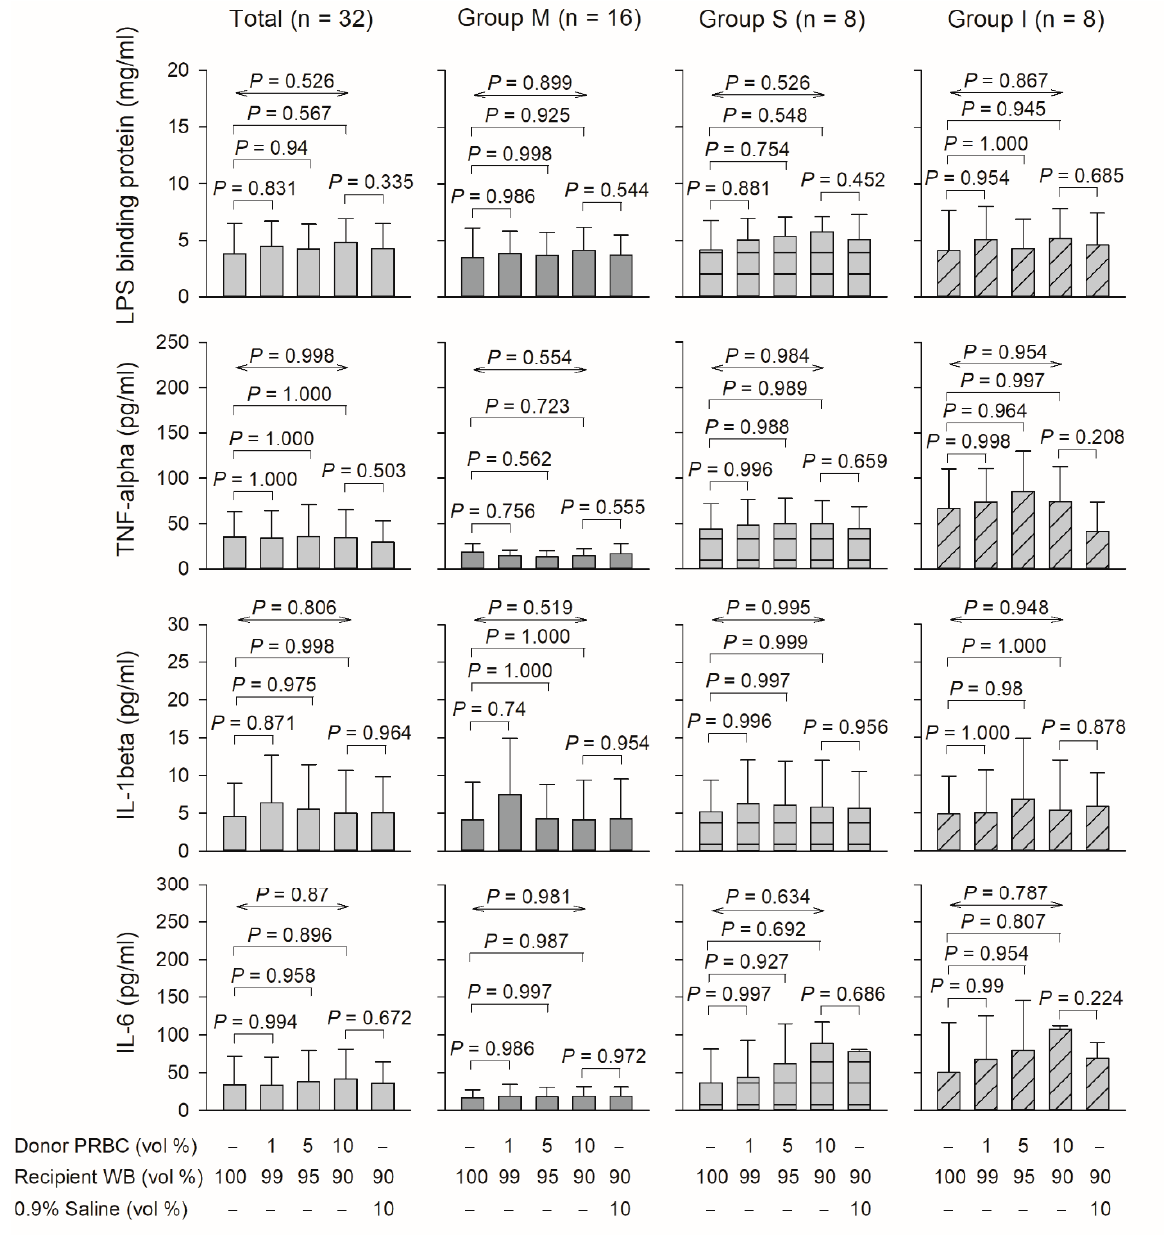
Figure 4. Effect of LPS-binding protein and proinflammatory cytokines in plasma prepared from mixing donor red blood cells and recipient whole blood on groups M, S, and I. RBCs, red blood cells; vol, volume; WP, washed platelets. Data are expressed as mean ± SD.